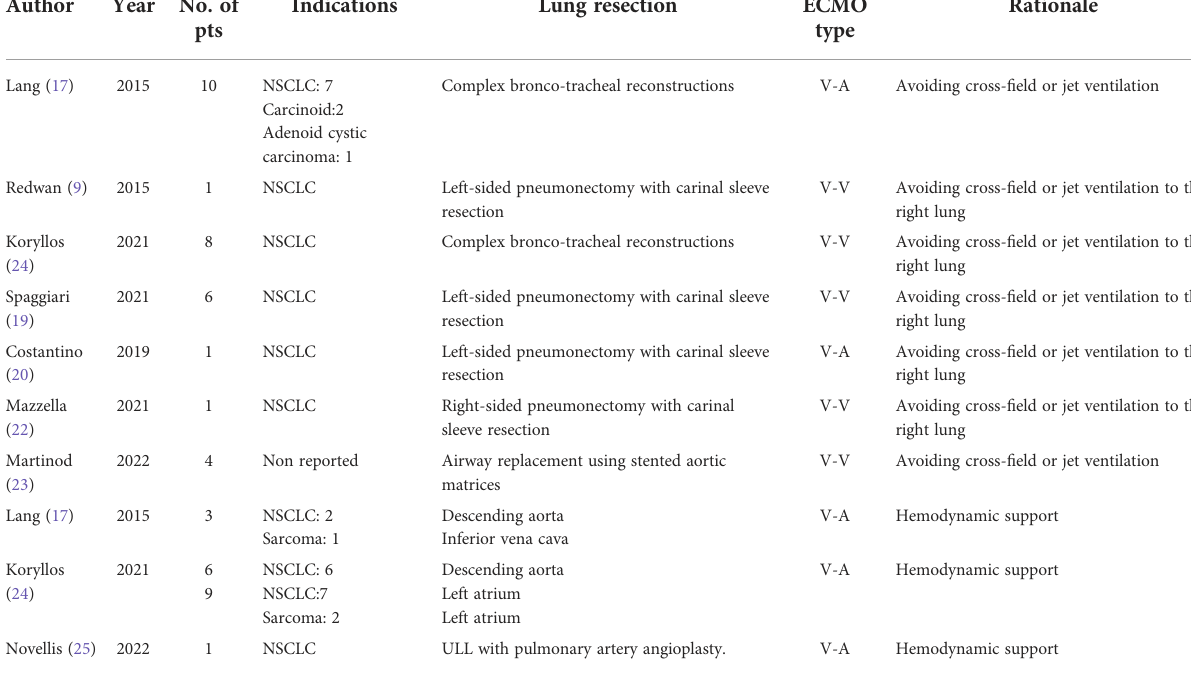
TABLE 2 Studies reporting the use of ECMO in oncological procedures requiring an obstacle-free surgical fi eld or both ventilatory and hemodynamic support.